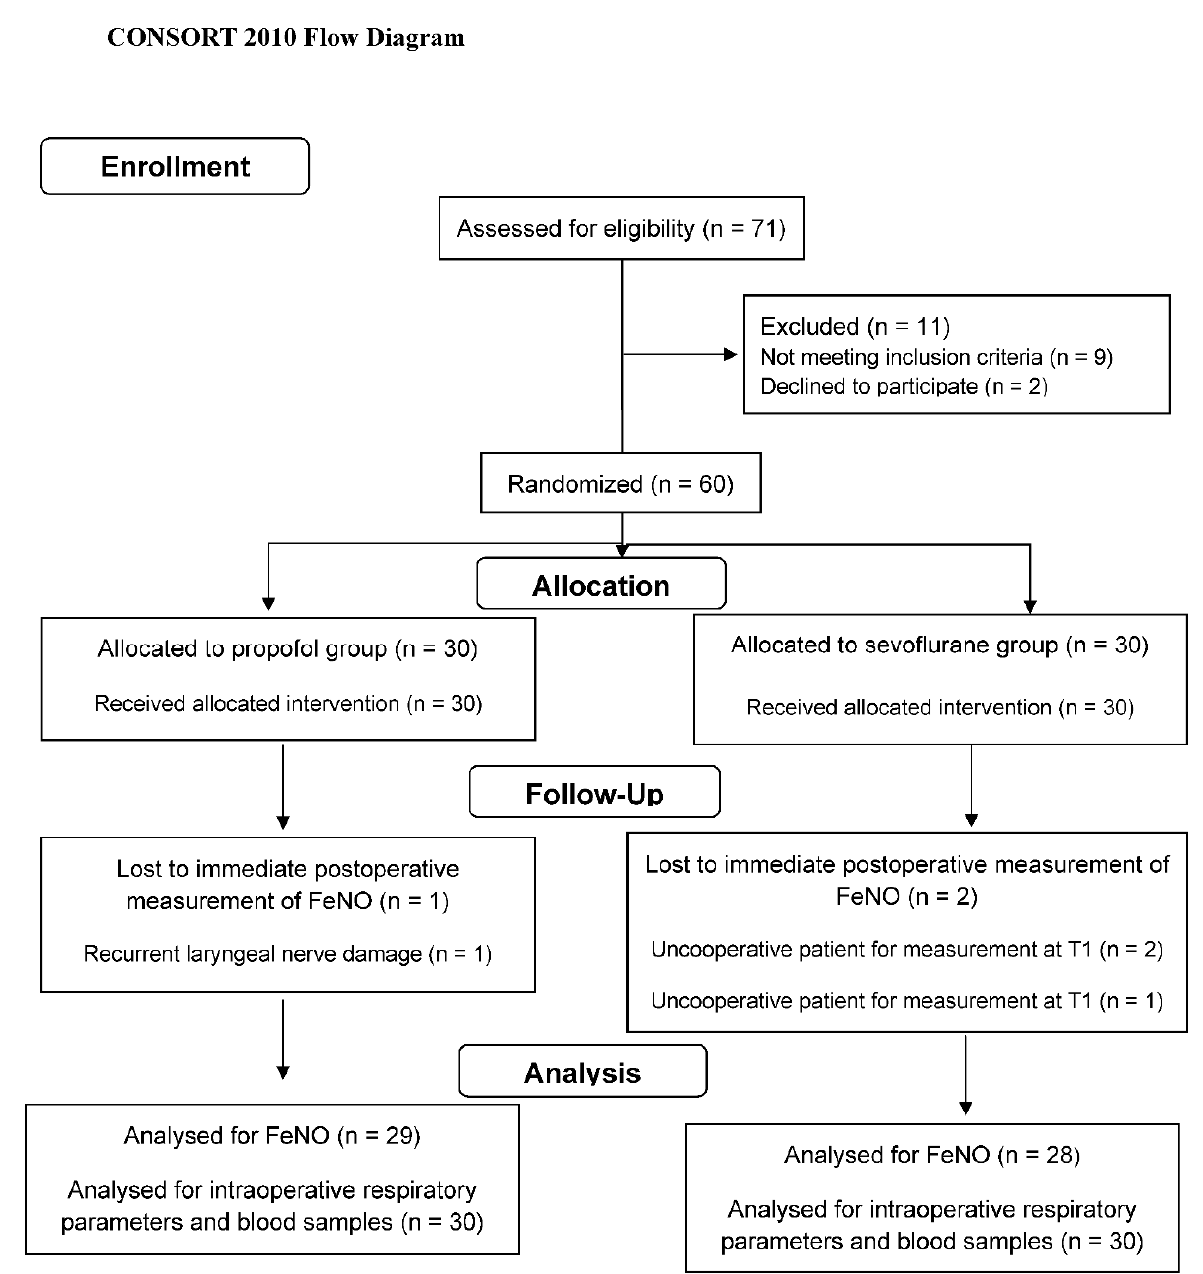
Figure 1. Study Flow Diagram.